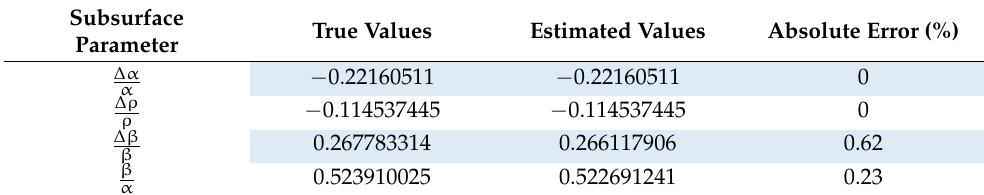
Table 6. Subsurface parameter values and absolute errors for CTP 63 in the gas channel.